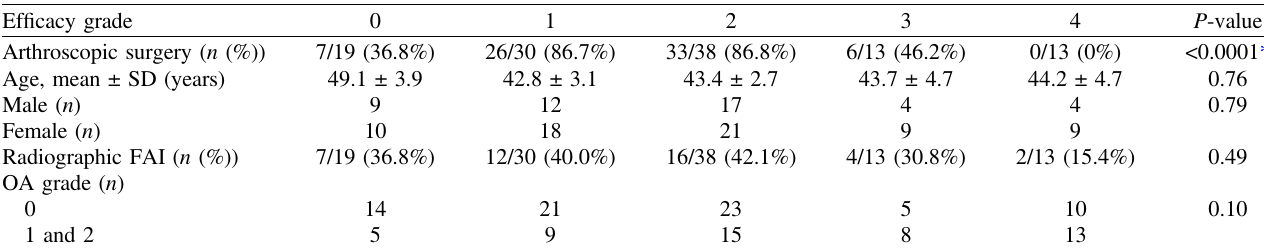
FAI: femoroacetabular impingement; OA: Osteoarthritis. * The Mann-Whitney U test or v 2 test showed a signi fi cant difference among the groups ( P <